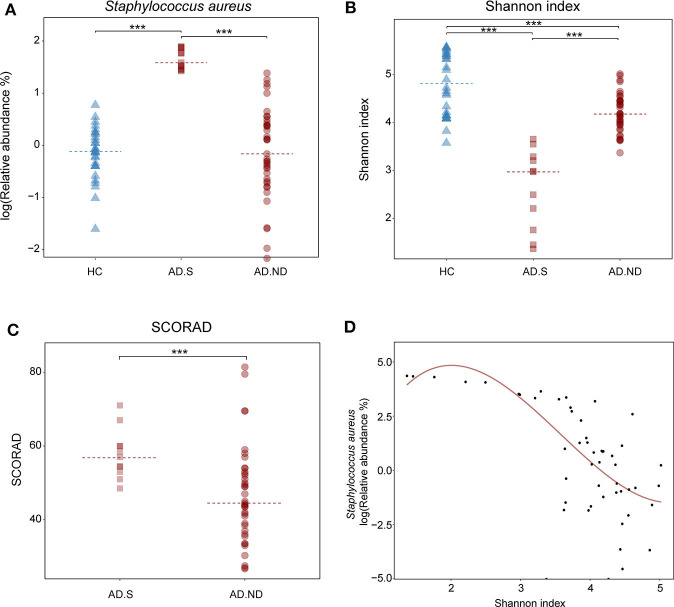
Microbial diversity and disease severity in the HC, AD.S and AD.ND groups. (A) Relative abundances of S. aureus in the three groups. ***P < 0.001. (B) Shannon index, reflecting microbial diversity. ***P < 0.001. (C) SCORAD index, reflecting the extent of the cutaneous injury in the AD patients. ***P < 0.001. (D) Correlation of cutaneous microbial diversity and relative abundance of S. aureus. ***P < 0.001 and R2 = 0.8. The samples in HC, AD.S and AD.ND groups were represented by blue triangles, maroon squares, and maroon circles, respectively.